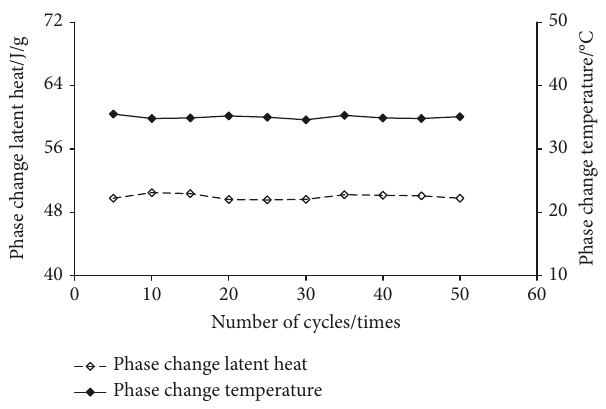
Figure 7: Phase change temperature and phase change latent heat of the 30% alkyl hydrocarbon PCS before and after multiple thermal cycles.